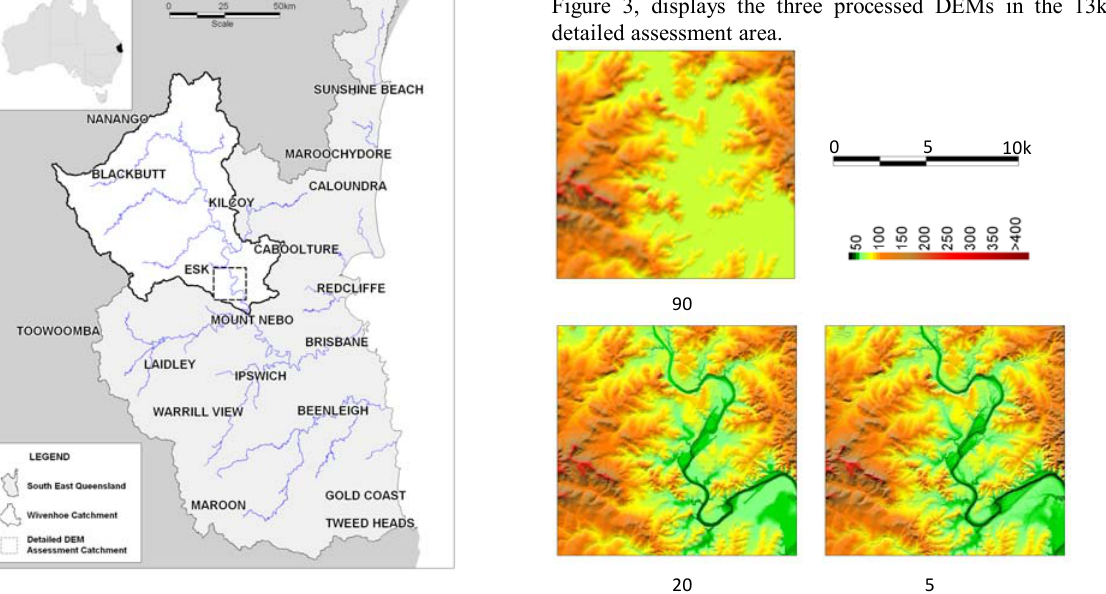
Figure 1. Study Areas